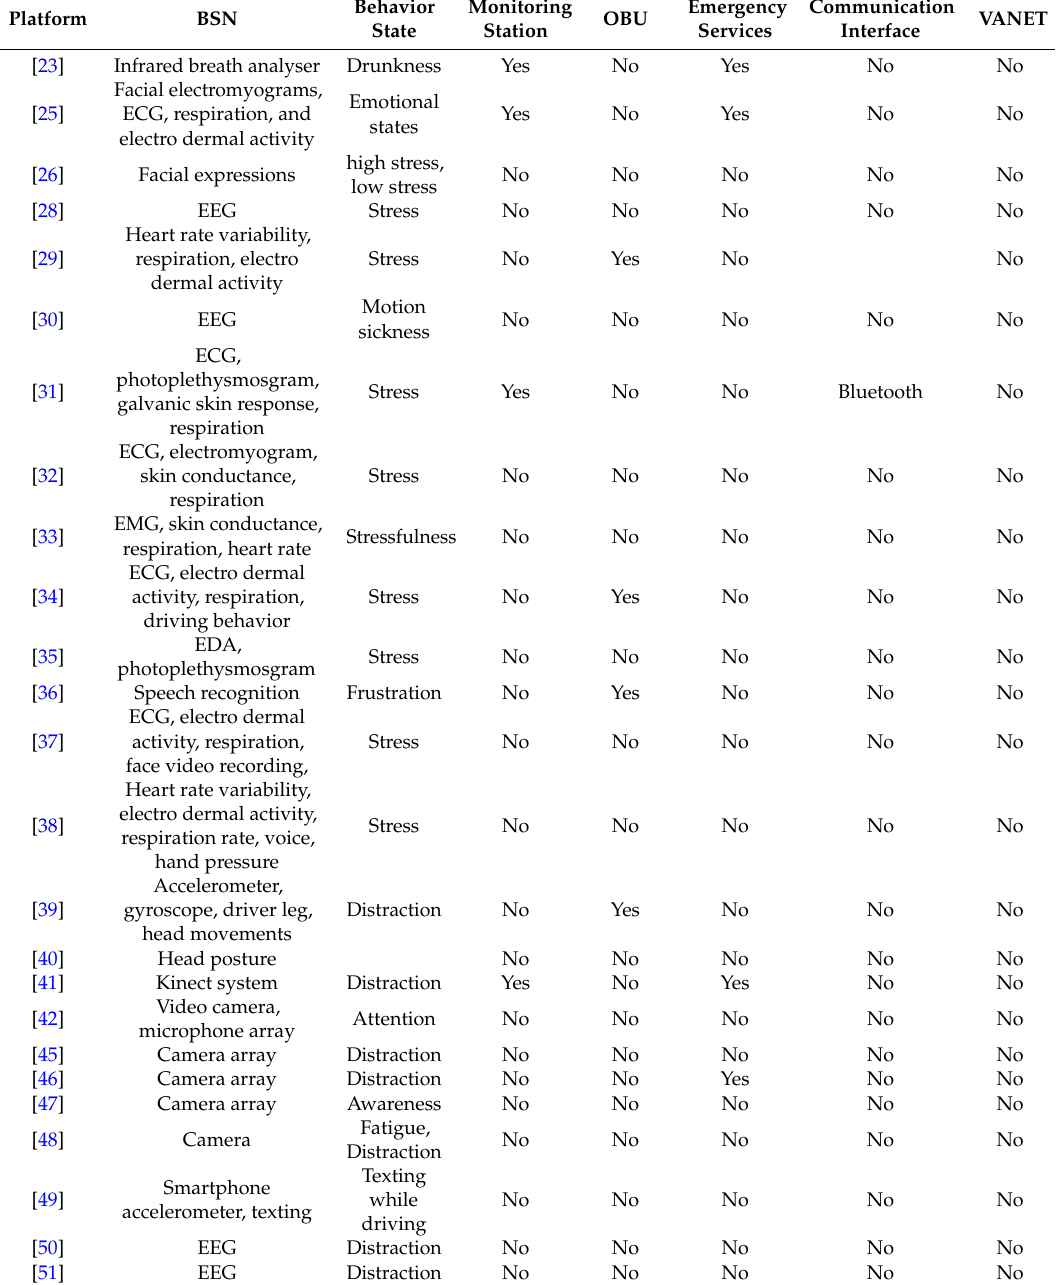
Communication Interface